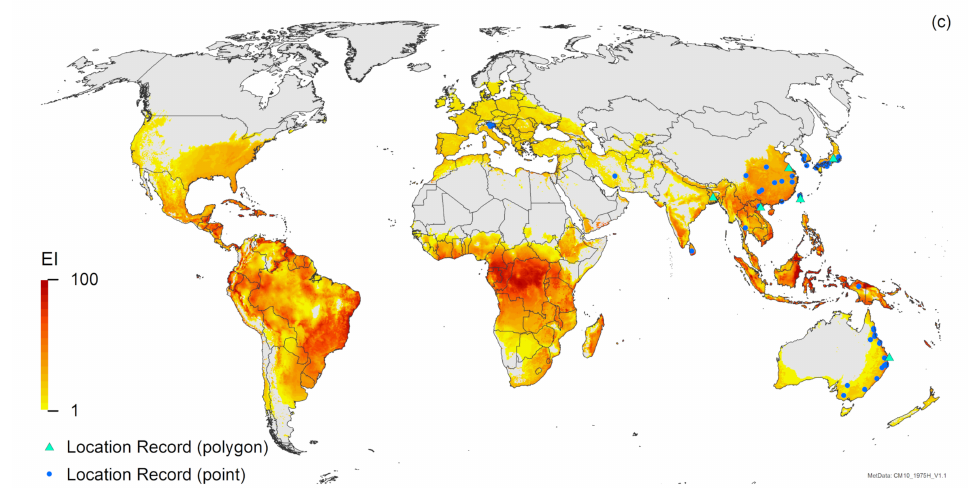
Figure 1. Modelled global climate suitability (CLIMEX Ecoclimatic Index) for ( a ) Halyomorpha halys [7], ( b ) Trissolcus japonicus [39] and ( c ) Trissolcus mitsukurii. Suitability for all three species is mapped as a composite of natural rainfall and irrigation based on identified irrigation areas [77]. Circles are point location records; triangles are polygon